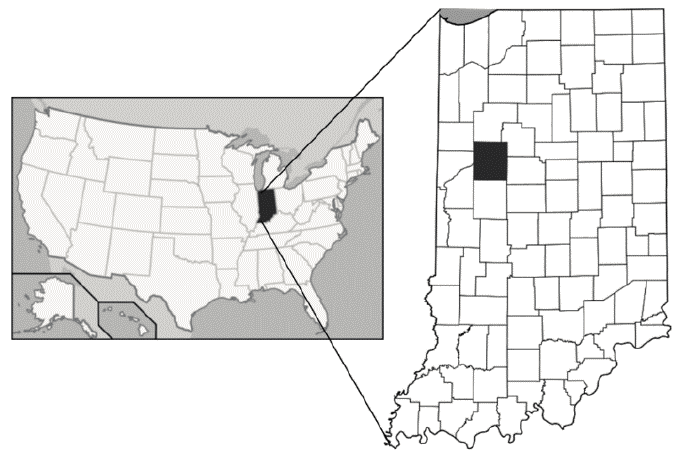
Figure 2. The study area is the Tippecanoe County that locates in the northwest quadrant of the U.S. state of